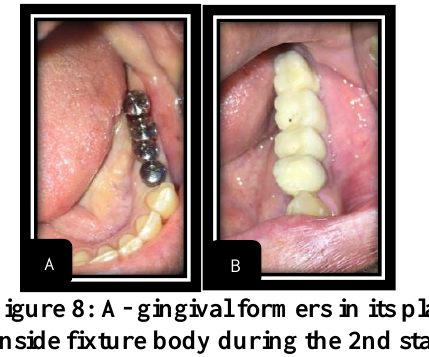
Figure 8: A- gingival formers in its place inside fixture body during the 2nd stage surgery. B- Final